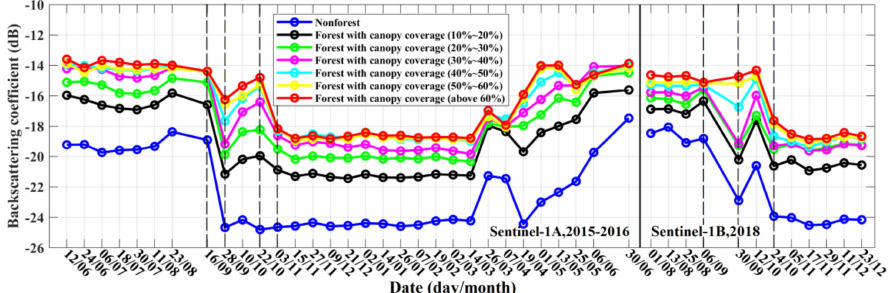
Figure 8. E ff ects of forest canopy coverage on the temporal behavior of backscattering using Sentinel-1 data. Lines in di ff erent colors indicate the statistical mean backscattering of statistics on di ff erent types of sampling